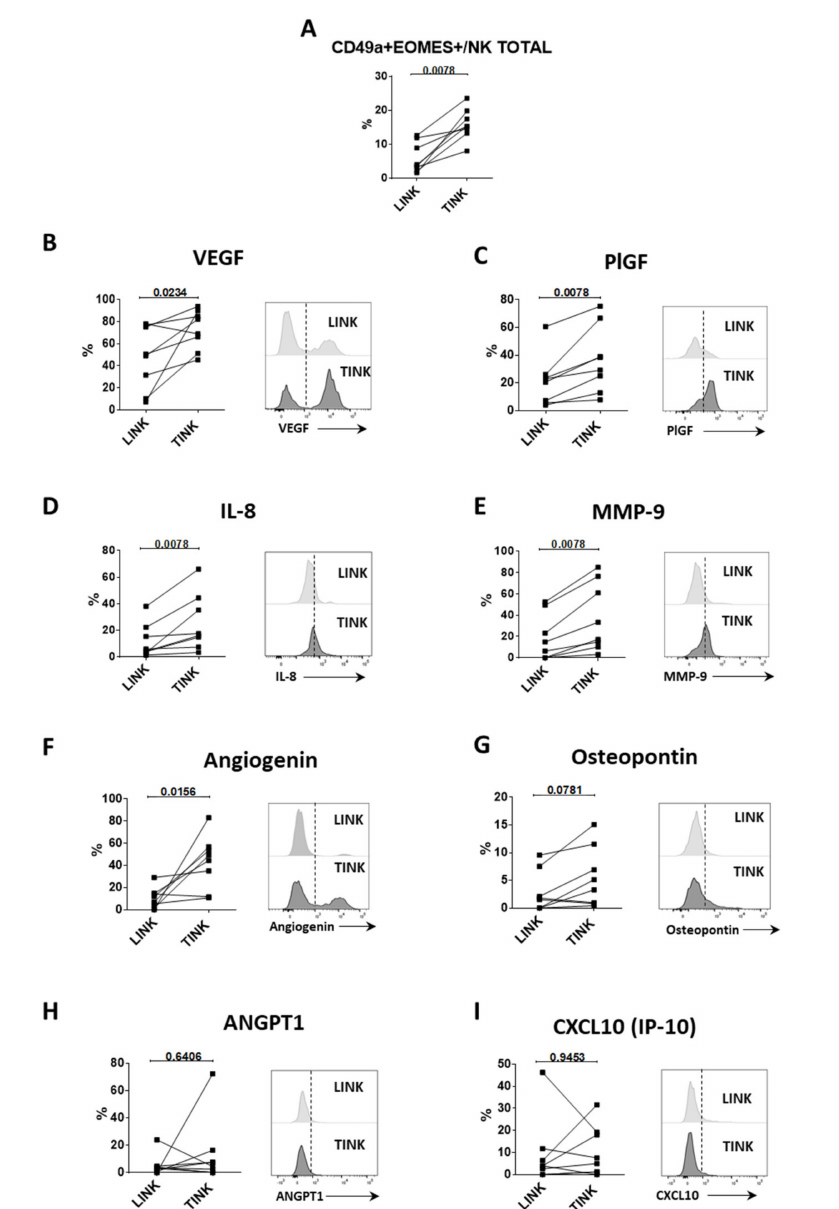
Figure 6. Production of proangiogenic factors by CD49a + Eomes + NK cells in LINK and TINK (n. 8). ( A ). Frequency of CD49a + Eomes + in total NK cells in the tumor and liver. VEGF ( B ), PlGF ( C ), IL-8 ( D ), MMP-9 ( E ), angiogenin ( F ), osteopontin ( G ), ANGPT1 ( H ), and CXCL10 ( I ) producing cells upon IL-12 and IL-18 stimulation. On the right side of each panel are representative histograms showing the MFI of each cytokine. Statistics by Wilcoxon matched pairs